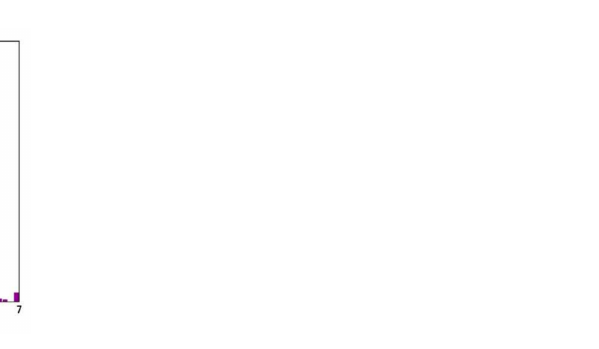
Figure 2. The distribution of the average check-in frequency for all POIs (note that we only show POIs with an average check-in frequency between 1 and 7, as the subsequent POIs display the same trend.)